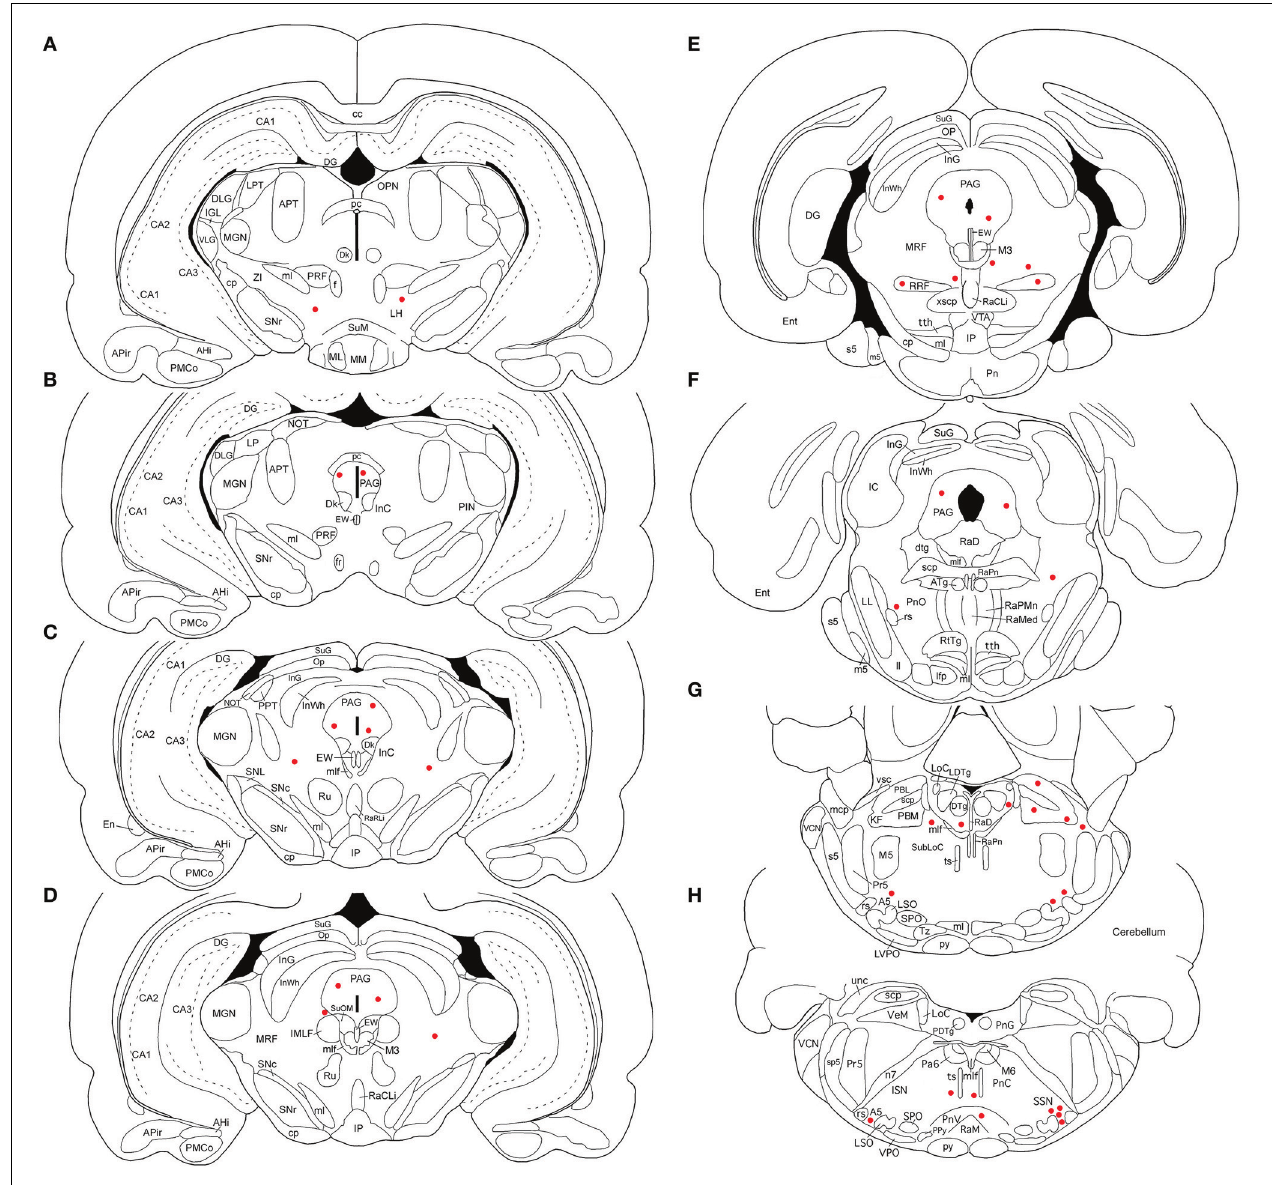
FIGURE 2 | Line drawing schematics of coronal sections through the midbrain and rostral hindbrain, based on the rat atlas of Paxinos and Watson (2009), showing the distribution of PRV + neurons in RF73.